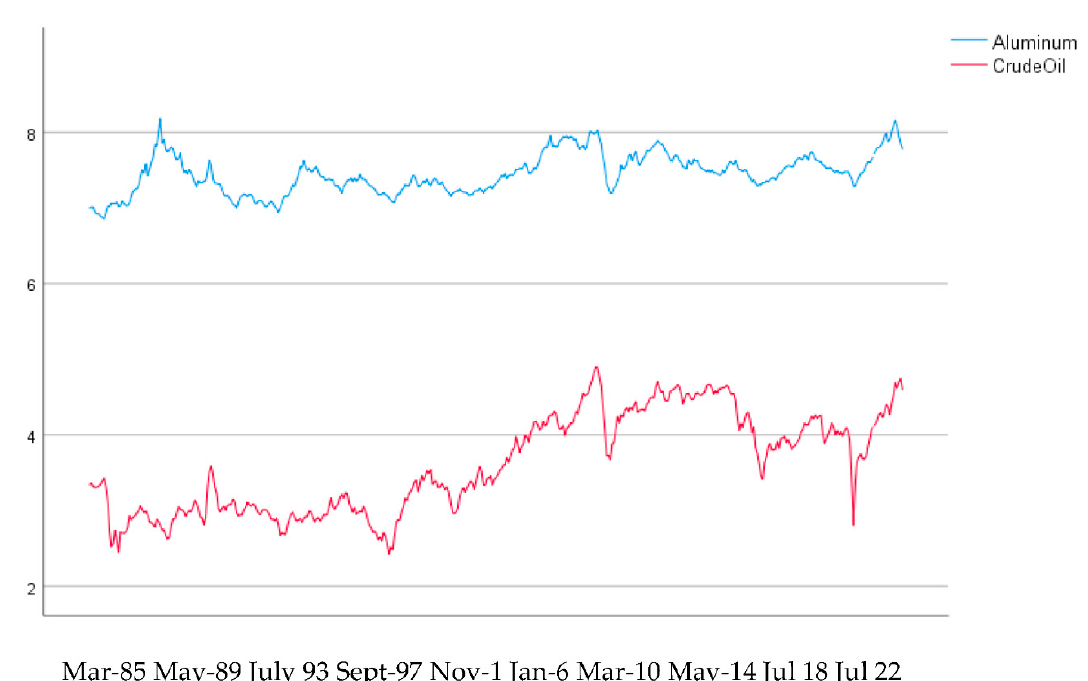
Figure 4. Time-Series (Logarithmic) Plot of Crude Oil and Aluminum Price Patterns. Proposition 5. There is a positive relationship between oil and gold prices .